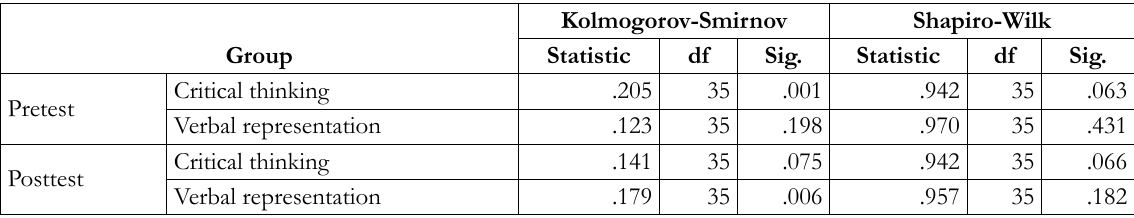
Table 5. Result of normality test of the control class